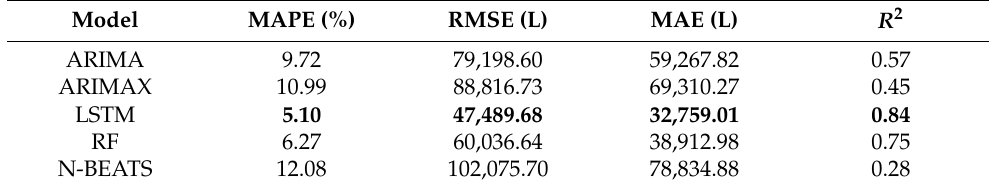
Table 9. Performance assessment for daily total BWD (bold indicates the best result for the corre- sponding shower room and